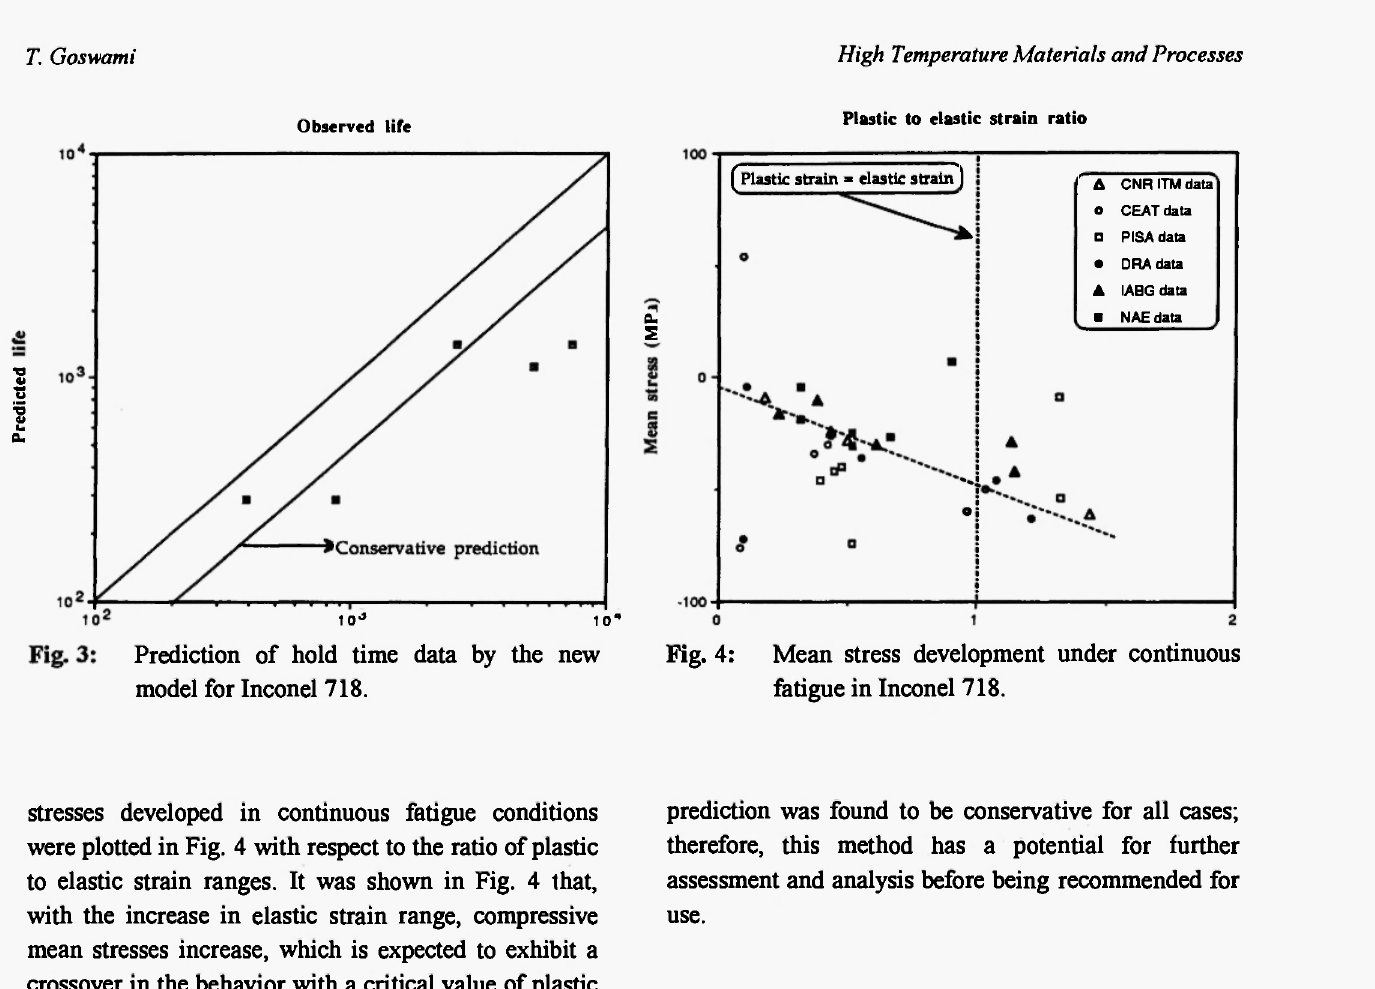
Fig. 4: Mean stress development under continuous fatigue in Inconel